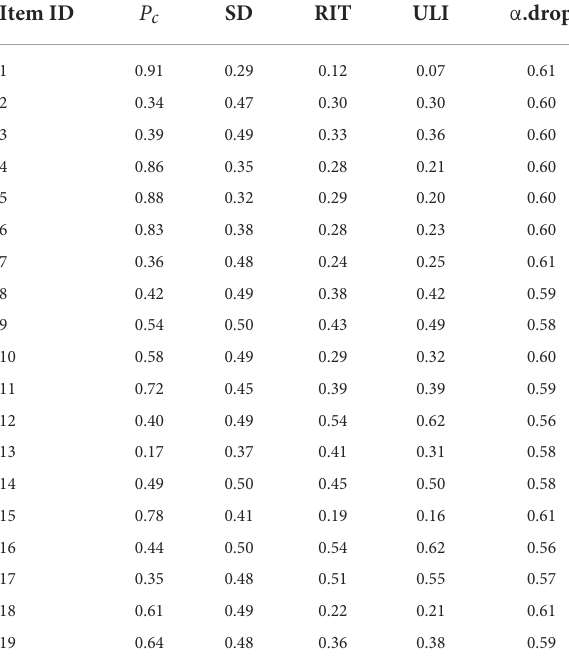
TABLE 1 Traditional item analysis